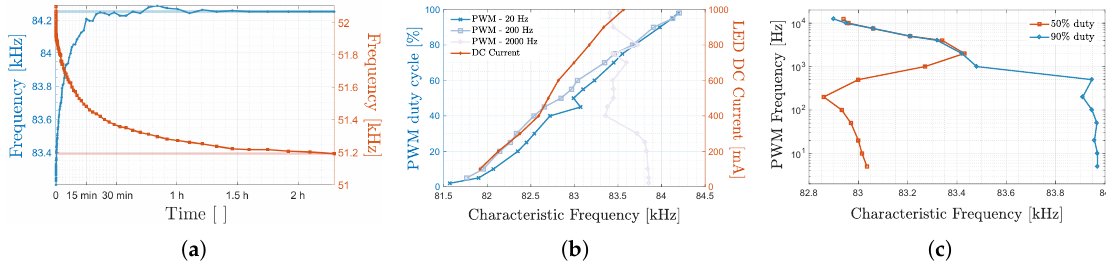
Figure 5. Characterising the characteristic frequency (CF) as a function of ( a ) time and compatibility with dimming with respect to ( b ) the average LED current and the ( c ) pulse-width modulation (PWM) frequency, for a BXRE chip on board (COB) LED measured on the ground in the positioning setup of Section